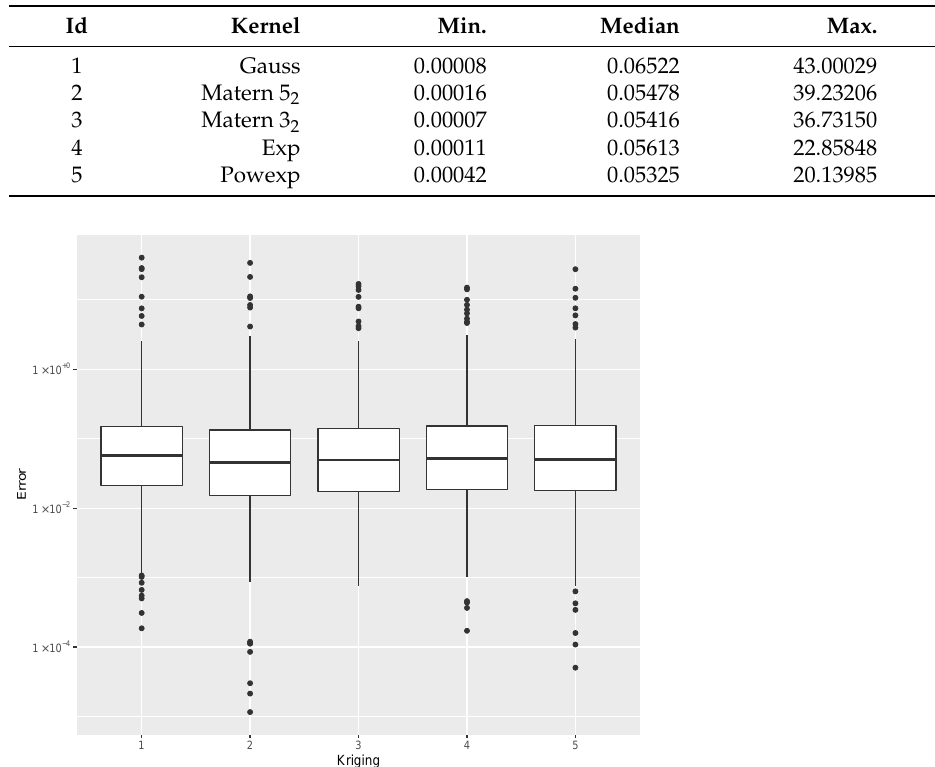
Table 6. Error statistics of the P critical estimate using a distinct Kriging covariance kernel structure.